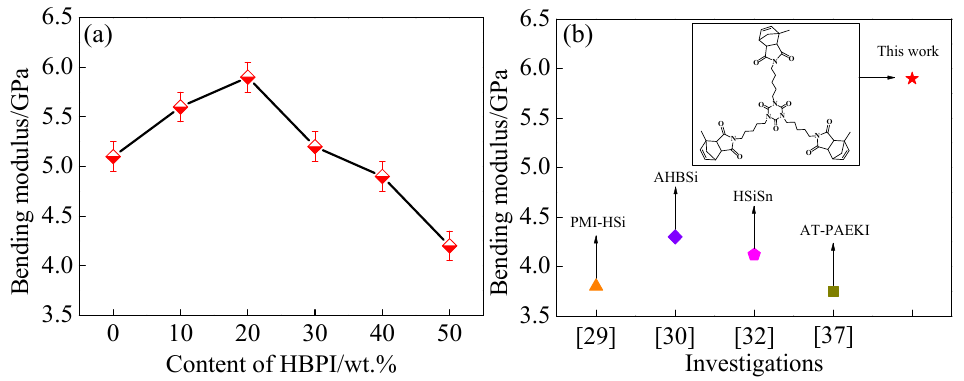
Figure 5. ( a ) Bending modulus of HBPI modified BMI resin with different content of HBPI, ( b ) Com-